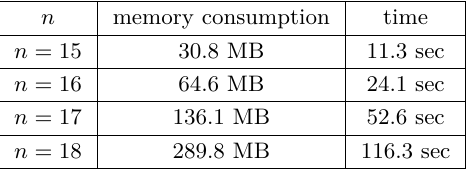
Table 2 Results for the LusSy benchmark verification using TLM.open